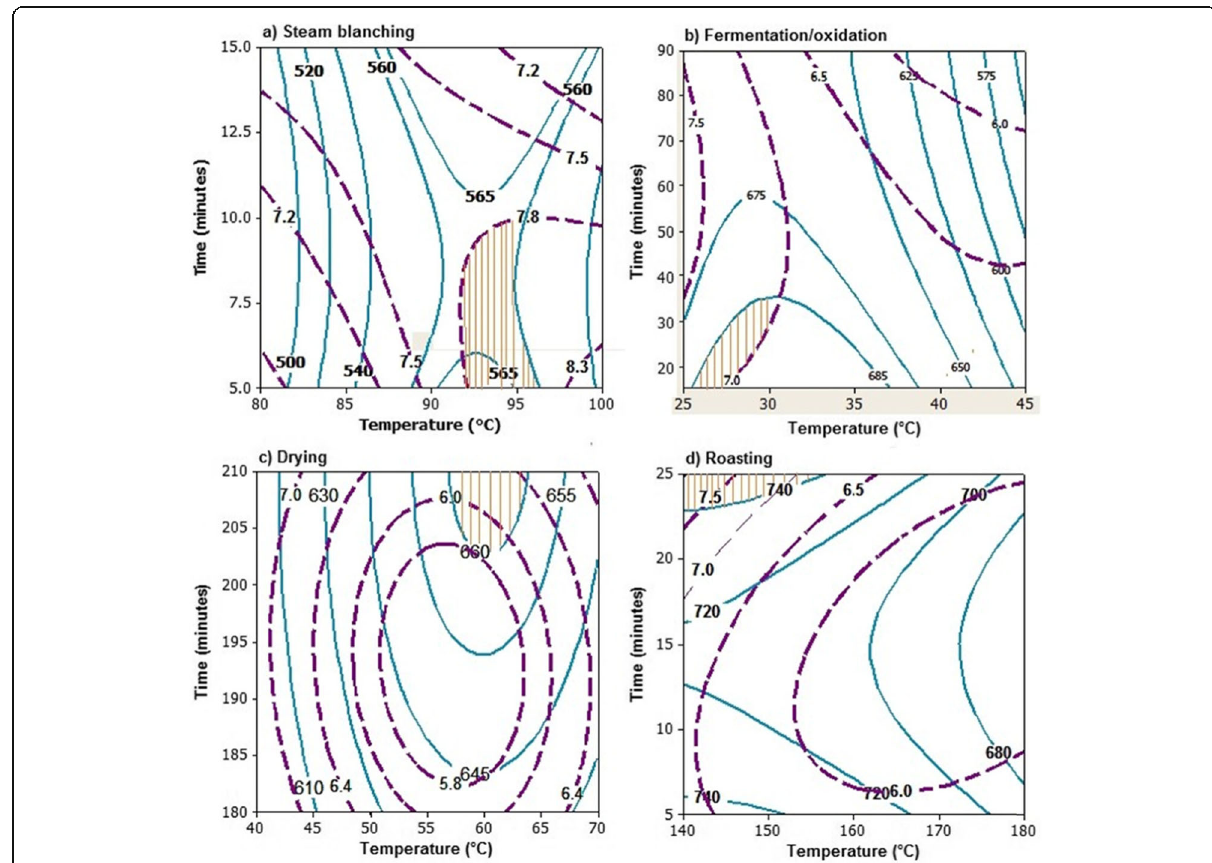
Fig. 1 Contour plots of the influence of temperature and time on TAC and DPPH scavenging activity for a Steam Blanched, b Fermented/ Oxidized, c Dried and d Roasted Moringa oleifera leaves. (Total Antioxidant Capacity (broken line); DPPH scavenging activity (solid